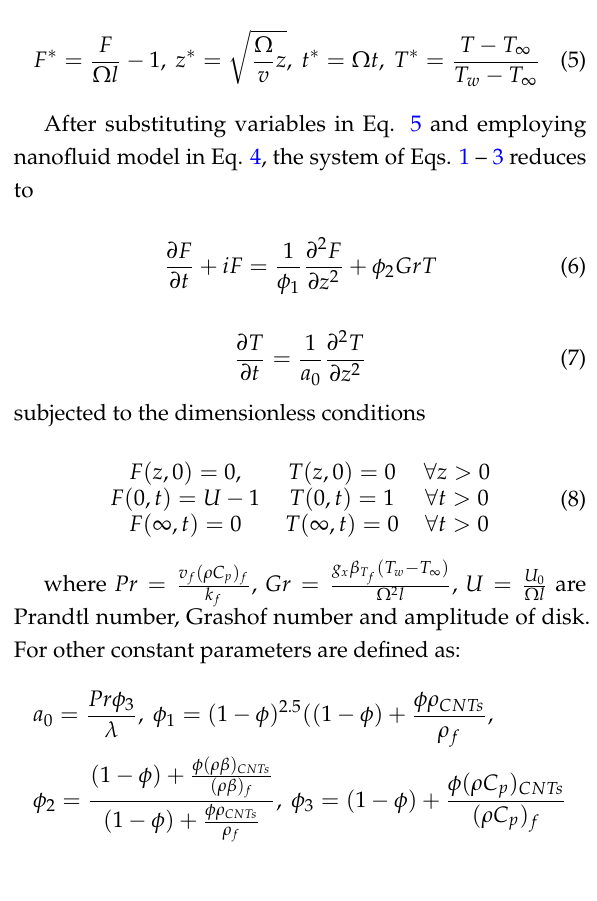
Fig. 1. Schematic diagram of the